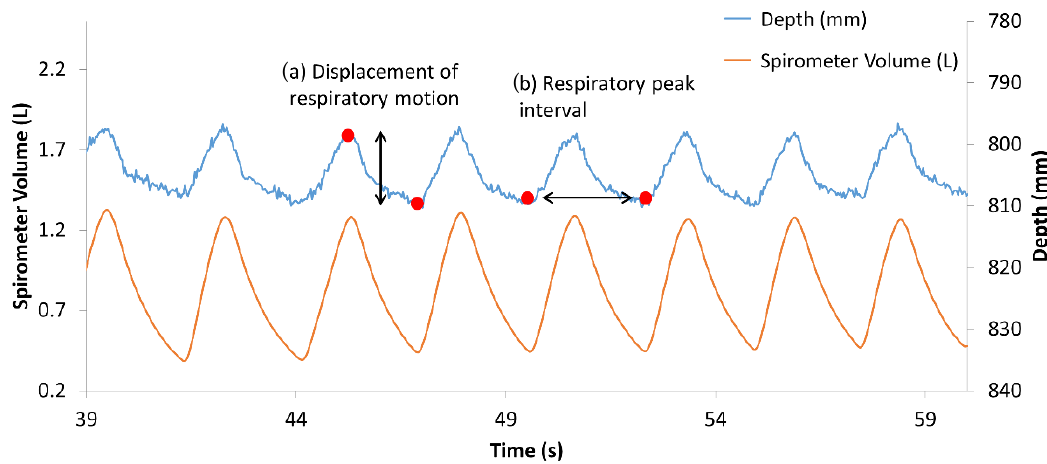
Figure 6. Data captured from the spirometer volume and depth camera.